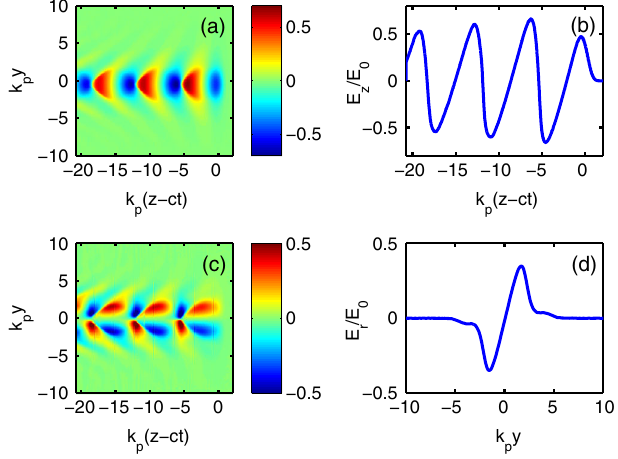
FIG. 3. Laser wakefields in the quasilinear regime: ð k y; k (cid:12) Þ =E , (b) its on-axis (a) longitudinal electric field E z p p 0 ð 0 ; k ð k (cid:12) Þ =E y; distribution E , (c) transverse electric field E z p r p 0 ð k k (cid:12) Þ =E y; (cid:1) 2 : 5 Þ =E , and (d) its transverse distribution E at p r p 0 0 ¼ 10 18 cm (cid:1) 3 , where (cid:12) ¼ z (cid:1) ct is the the plasma density n e coordinate moving with the laser pulse from the left to the